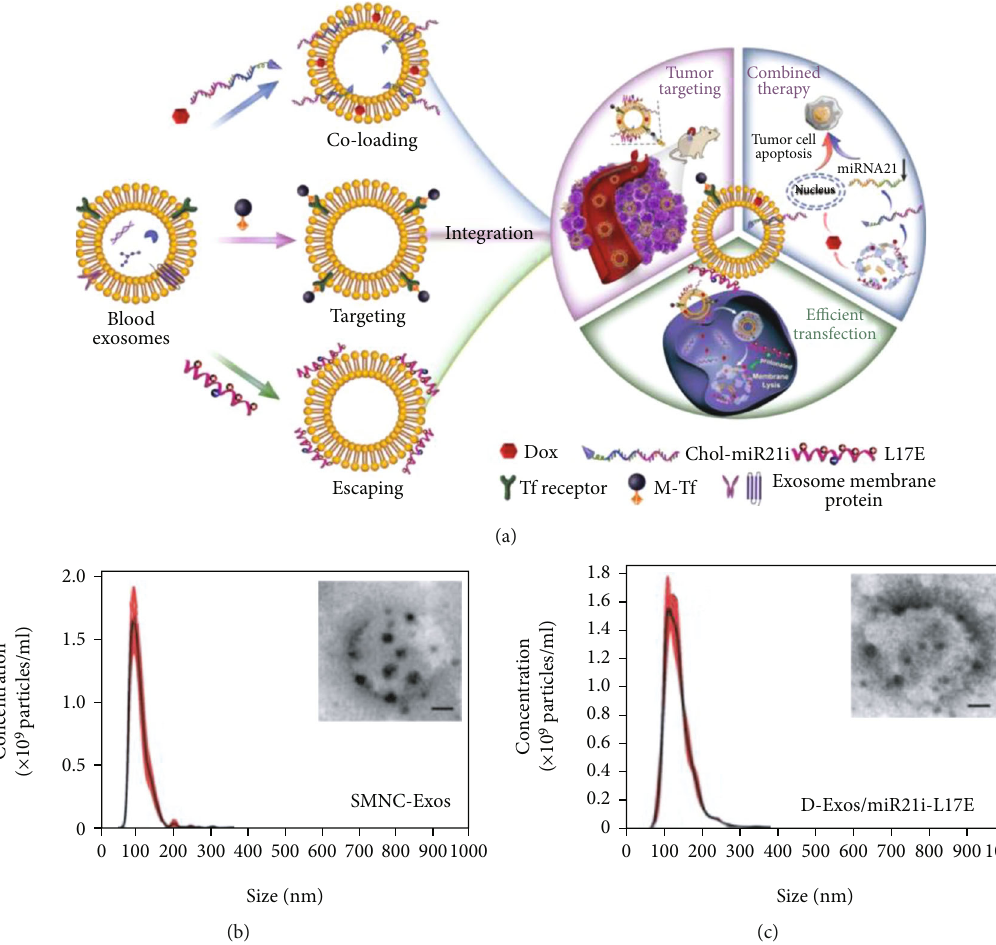
Figure 5: (a) Scheme of gene/chemotherapy on a blood exosome basis. Chemotherapeutic drugs and the cholesterol-modi fi ed miRNA21 inhibitor were embedded between the vesicle lipid bilayers for tumor killing; both magnetic molecules and L17E peptides were bound onto the vesicle membrane, respectively, for targeting and lysosome escape. (b) According to nanoparticle tracking analysis (NTA), the original exosome size was 93 nm. (c) The size was increased to 106 nm on average, after cargo loading and membrane modi fi cation, and transmission electron microscope (TEM) images showed modi fi ed exosomes that retained a clustered structure. Reproduced